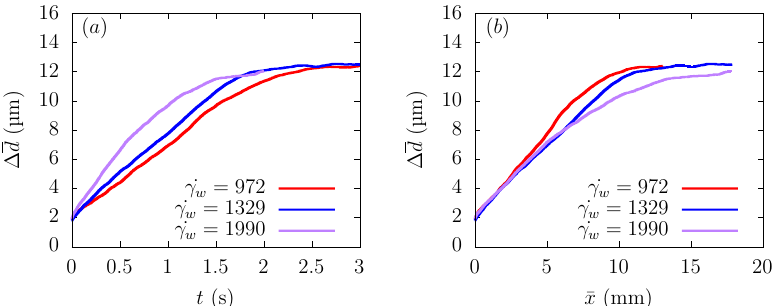
Figure 6. Ensemble-averaged distance d from the centerline of the channel at average wall shear rates ˙ γ w = 972 s − 1 , 1329 s − 1 , and 1990 s − 1 . ( a ) Time history of d . ( b ) Change of d as a function of distance traveled in the flow direction x